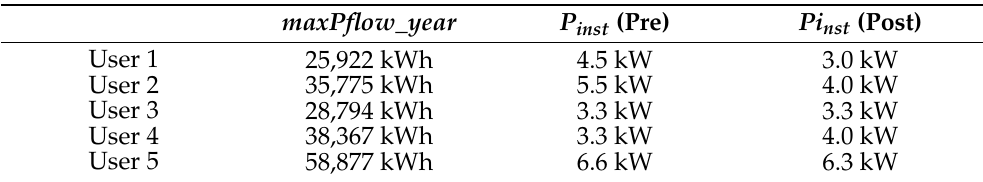
Table 7. Maximum power/energy flow through the meter, the current power and the adjusted value for each